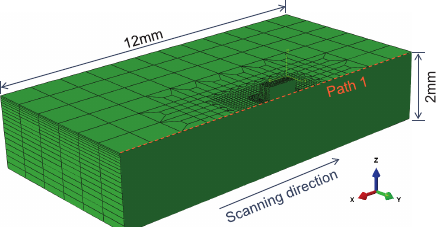
Figure 2. The finite element model contains two parts: the powder layer and the substrate. The dimension of the substrate is 12 × 10 × 2 mm, and the area of the powder layer is 1.2 × 0.6